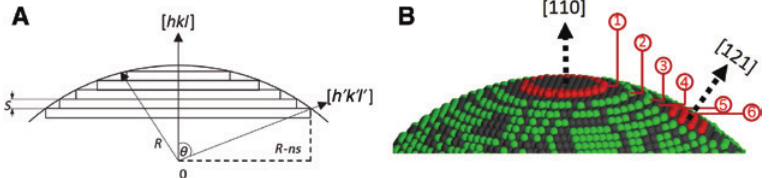
Figure 5: (A) A schematic showing a lateral view of a tip. (B) A ball model with a radius of 10 nm corresponding to the schematic in